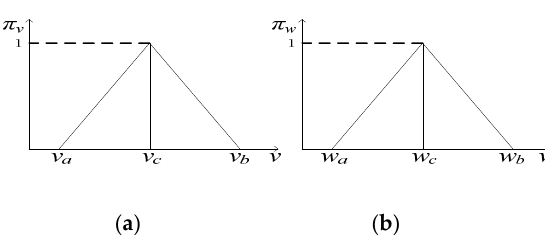
Figure 2. ( a ) Triangle possibility distributions of state noises, ( b ) Triangle possibility distributions of observation noises.